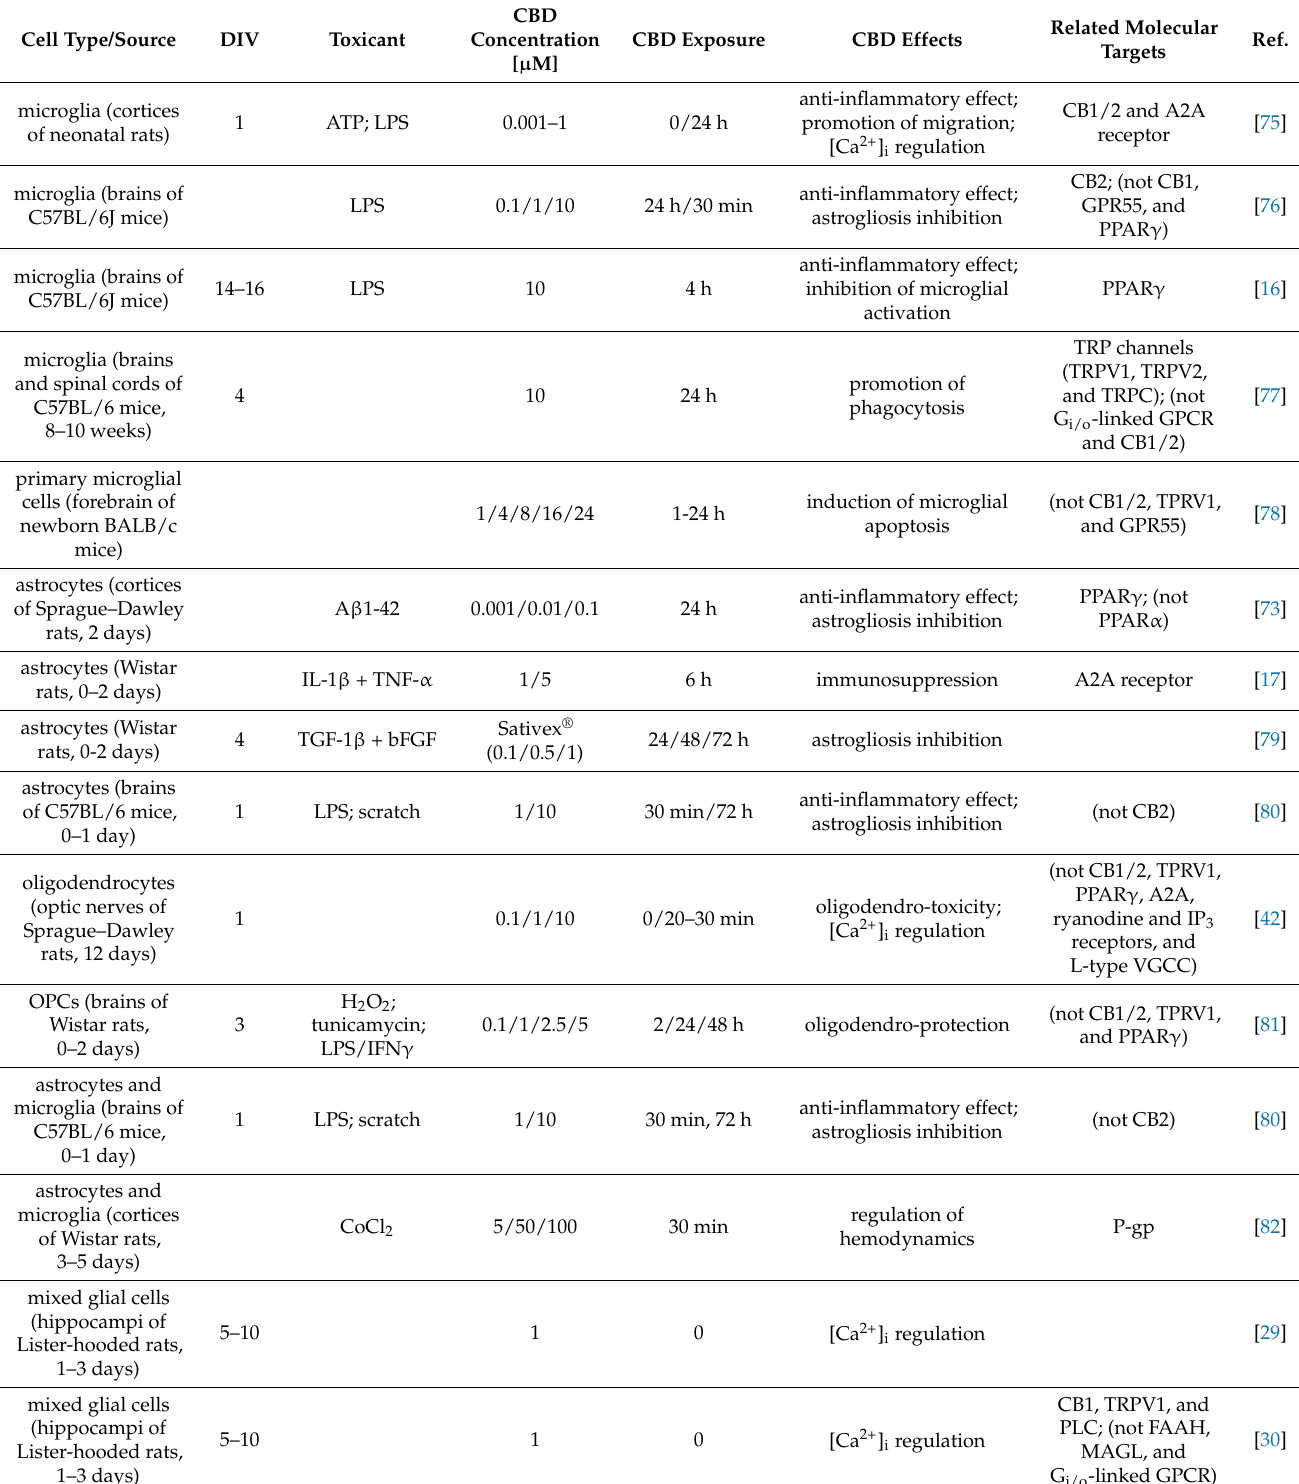
Table 2. CBD actions on primary